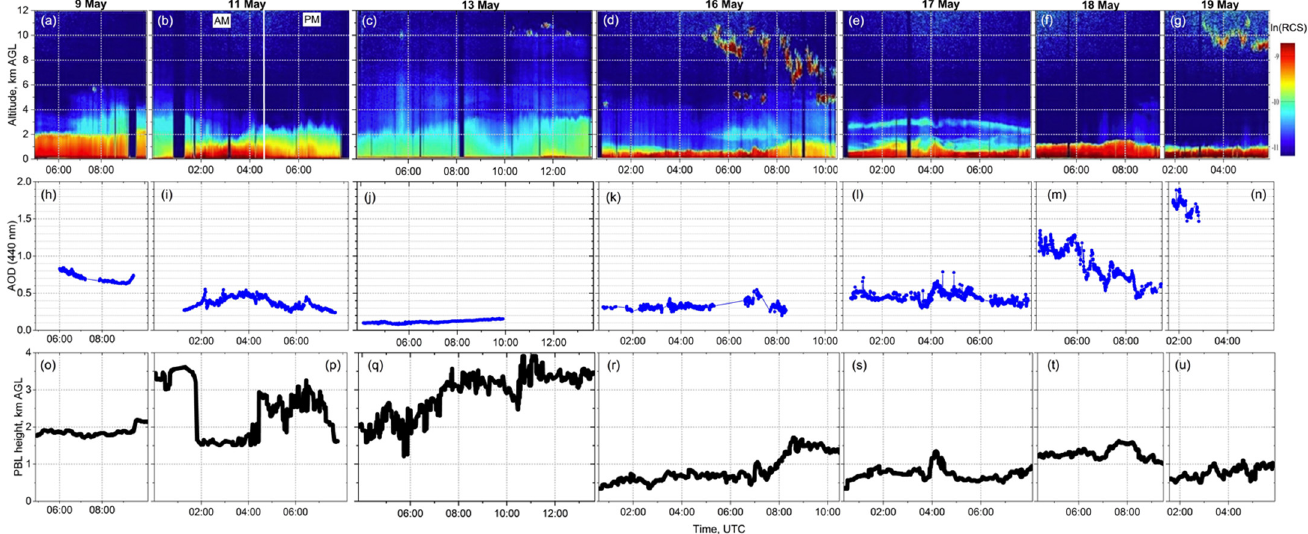
Figure 3. (Top panels ( a – g )) Spatio-temporal and vertical variability of aerosol layers and clouds, color-coded by LIDAR Range Corrected Signal (RCS) as measured along the mobile transects de- tailed in Table 2 and depicted in Figure 2; (Middle panels ( h – n )) AOD at 440 nm; (Bottom panels ( o – u )) PBL heights from mobile LIDAR